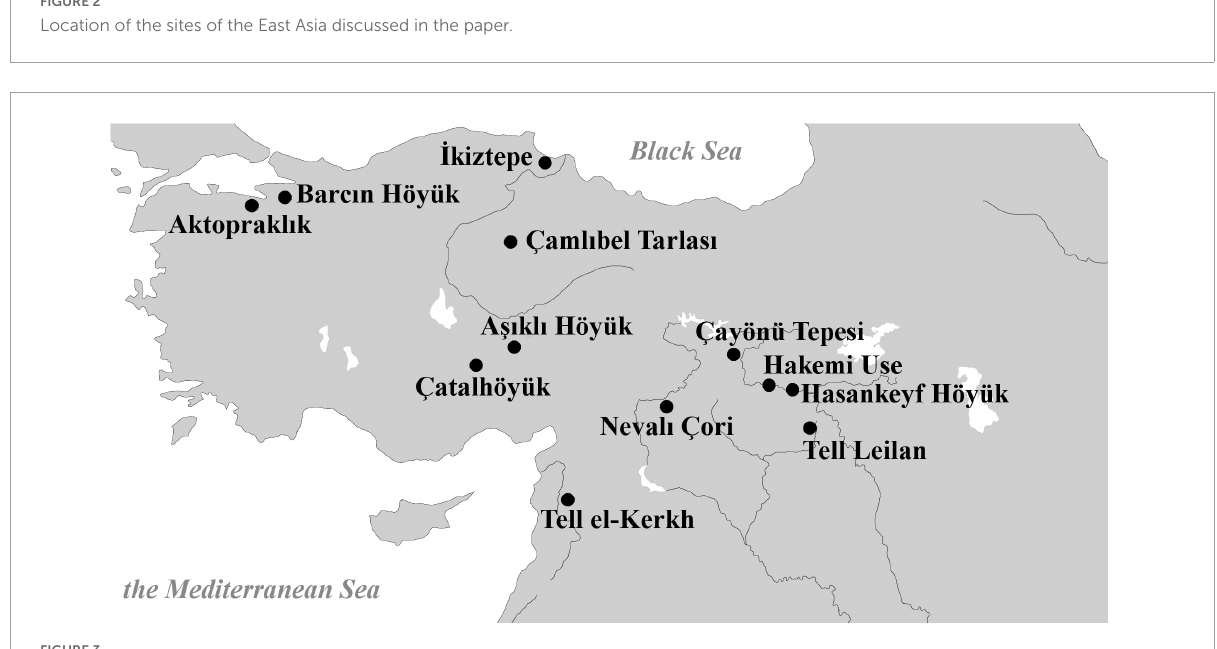
FIGURE3 Location of the sites of the Near East discussed in the